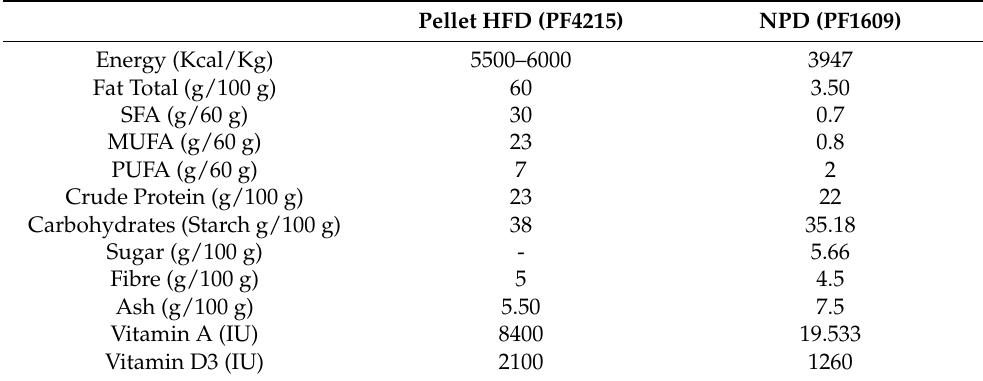
Table 1. Pellet compositions are reported for both HFD and NPD. (SFA) Saturated Fat Acid, (MUFA) Monounsaturated Fatty Acid, (PUFA) Polyunsaturated Fatty